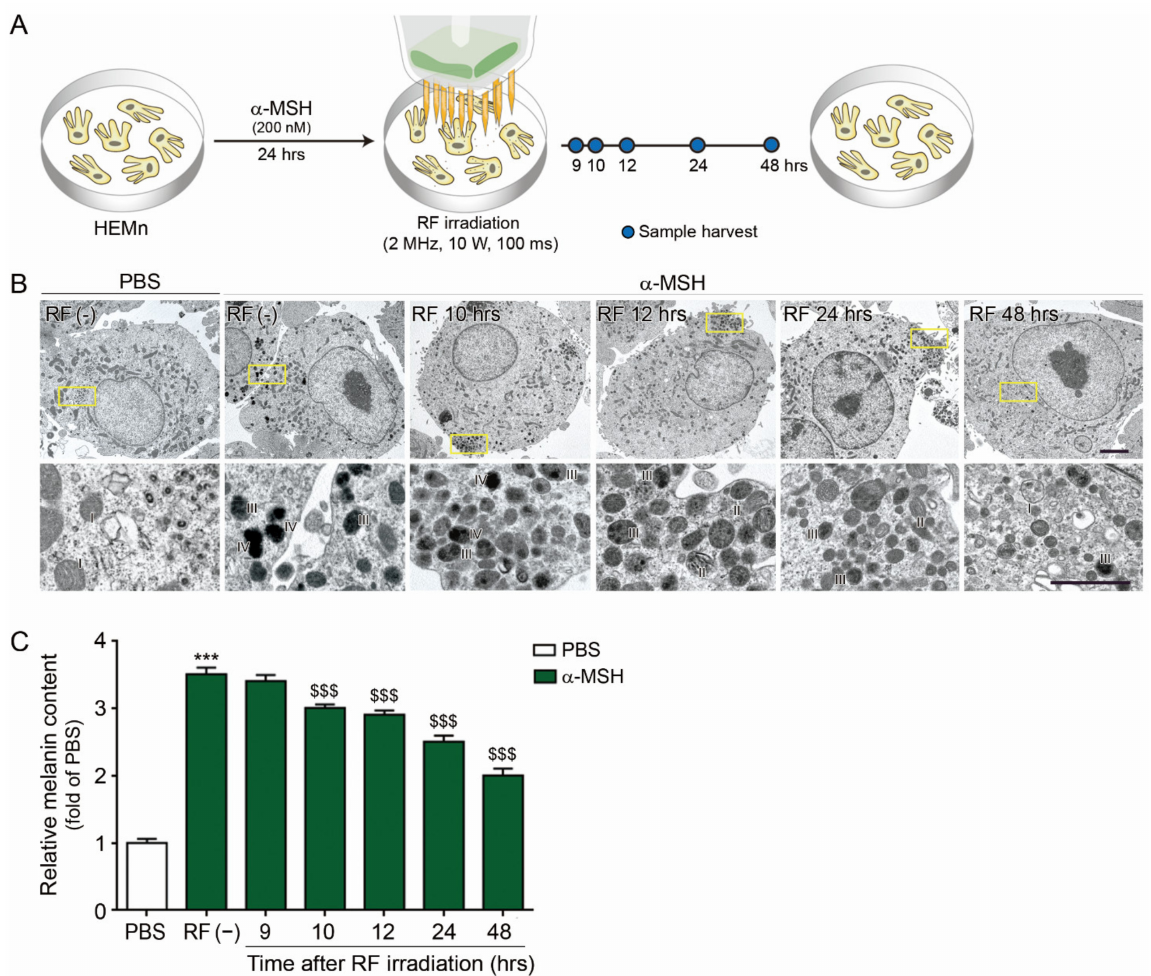
Figure 2. Attenuated effects of melanin synthesis and formation of stage IV melanosomes by RF. ( A ) Diagram of the in vitro model used to validate the melanin reduction mechanism. ( B ) Change in melanosome maturation with time after RF irradiation in TEM. ( C ) Change in the melanin content of α -MSH-treated HEMn. α -MSH, α -melanocyte stimulating hormone; HEMn, human epidermal melanocyte cells; RF, radiofrequency; TEM, transmission electron microscope; UV-B, ultraviolet-B; ***: p < 0.001 vs. PBS; $$$: p < 0.001 vs. α -MSH/RF ( −